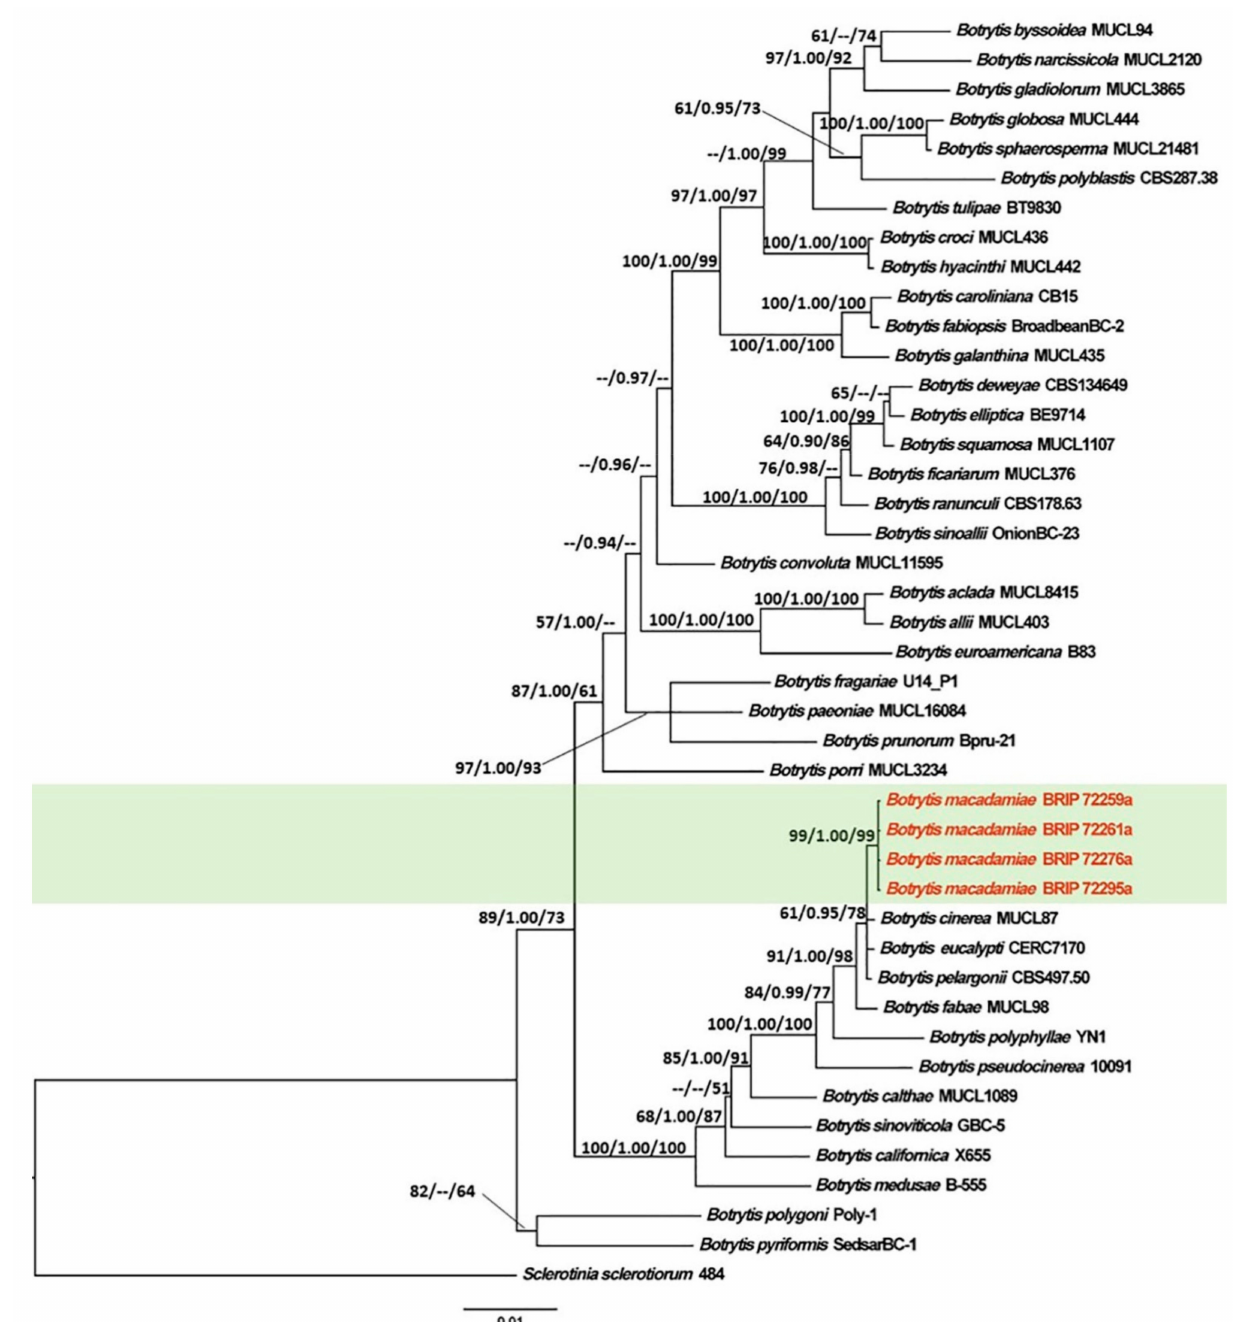
Figure 2. Maximum Likelihood tree topology of Botrytis based on a concatenated multi-locus alignment ( RPB2 + HSP60 + G3PDH ). Sclerotinia sclerotiorum 484 was used as an outgroup taxon. Maximum Likelihood bootstrap support values (>50%), Bayesian Inference posterior probabilities (>90%), and Maximum Parsimony bootstrap proportions (>50%) are displayed at the nodes, respectively. Isolates of the newly described species are depicted in